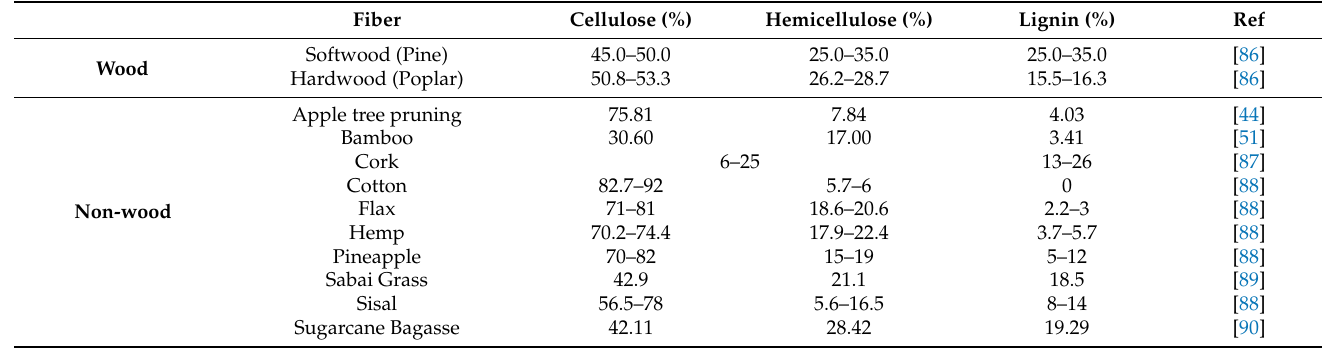
Table 2. Lignocellulosic fibers